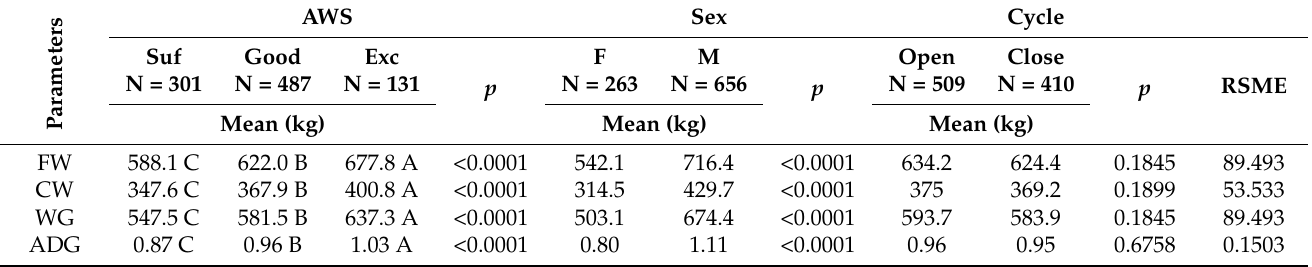
Table 5. Influence of AWS class, sex, and breeding technique (cycle) on FW, CW, WG, and